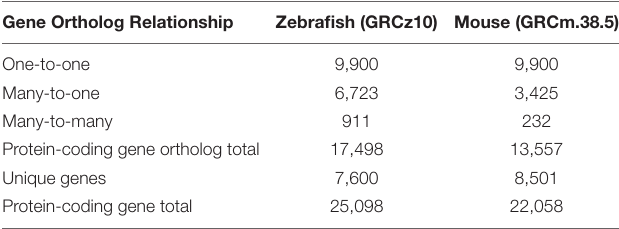
TABLE 1 | Classification of orthologous relationships of zebrafish and mouse protein-coding genes. Gene Ortholog